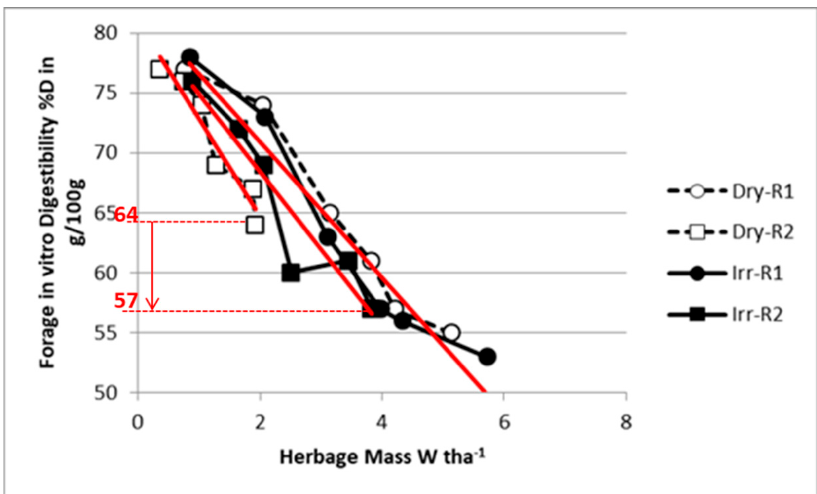
Figure 3. Relationship between in vitro forage digestibility (%D) and forage mass (W) of alfalfa during two successive regrowths (R1: 15th May–1st July and R2: 1st July–15 August), under irrigated (Irr) and non-irrigated (Dry) conditions. Linear regressions are: %D = 82–5.67W, R 2 = 0.94 for both irrigated and non-irrigated R1; %D = 81–6.44W, R 2 = 0.89 for irrigated R2; and %D = 81–8.17W, R 2 = 0.92 for non-irrigated R2. (Data obtained at Lusignan (46.46° N; 0.07° E; France) and re-calculated from Lemaire et al. [30]).